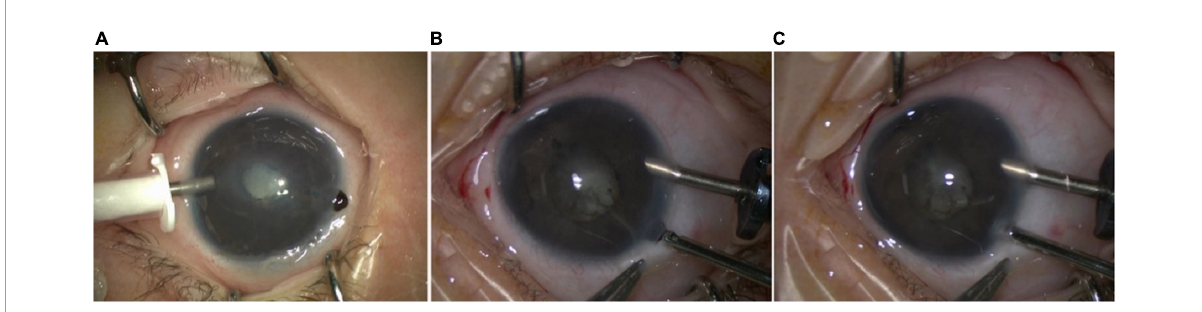
FIGURE3 The intraoperative complication of iris incision. The major intraoperative complication of iris incision was iris incarceration (A) . The incarcerated iris can be easily returned to the anterior chamber with the assistance of surgical instruments or a viscoelastic agent (B,C) .